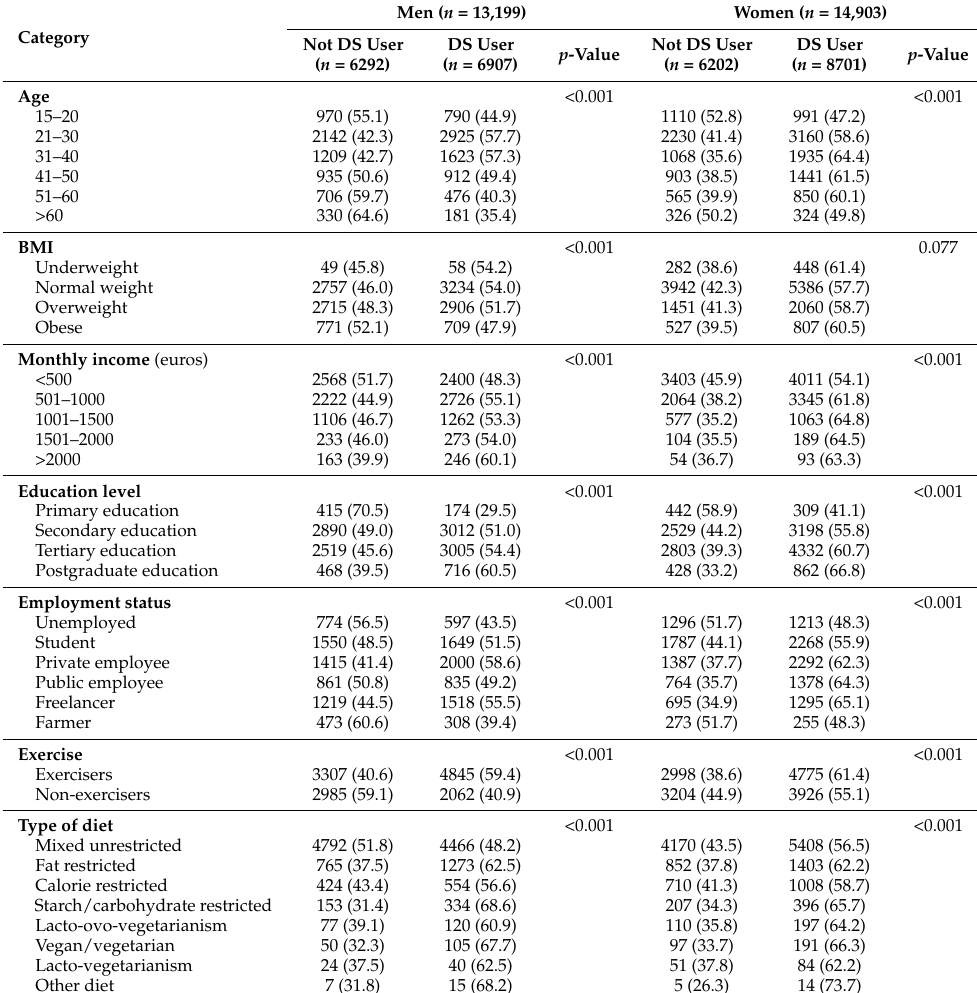
Table 2. Absolute and relative frequencies in parenthesis (%) of personal and demographic character- istics according to sex and DS use. The p -values of chi-square tests are